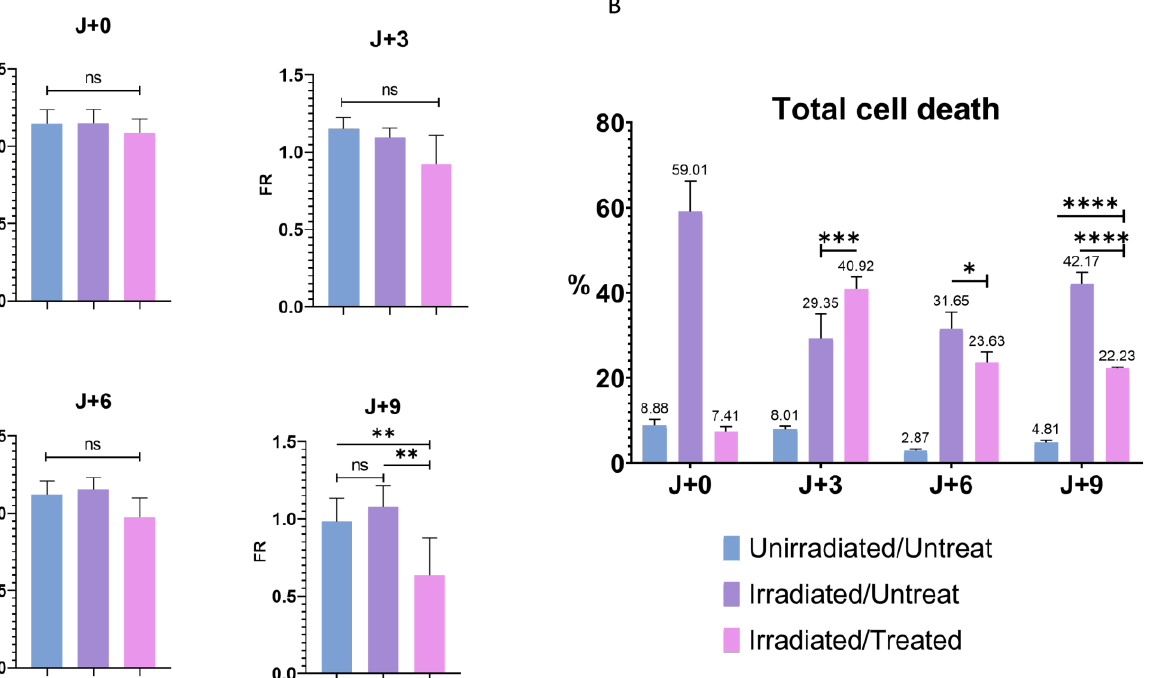
Figure 6. Cell death and PMF. ( A ) Quantitative determination of PMF after irradiation- and treatment-induced senescence on T24 cells at J+0, J+3, J+6, and J+9. Bar graphs represent the mean (SD) (ns > 0.05; ** p < 0.01). ( B ) Flow cytometry determination of early apoptosis, late apoptosis and necrosis combined after induction of cellular stress by irradiation and treatment on T24 cells, labeled with annexin V and propidium iodide. Bar graphs represent the mean (SD) (* p < 0.05; *** p < 0.001); **** p < 0.0001).